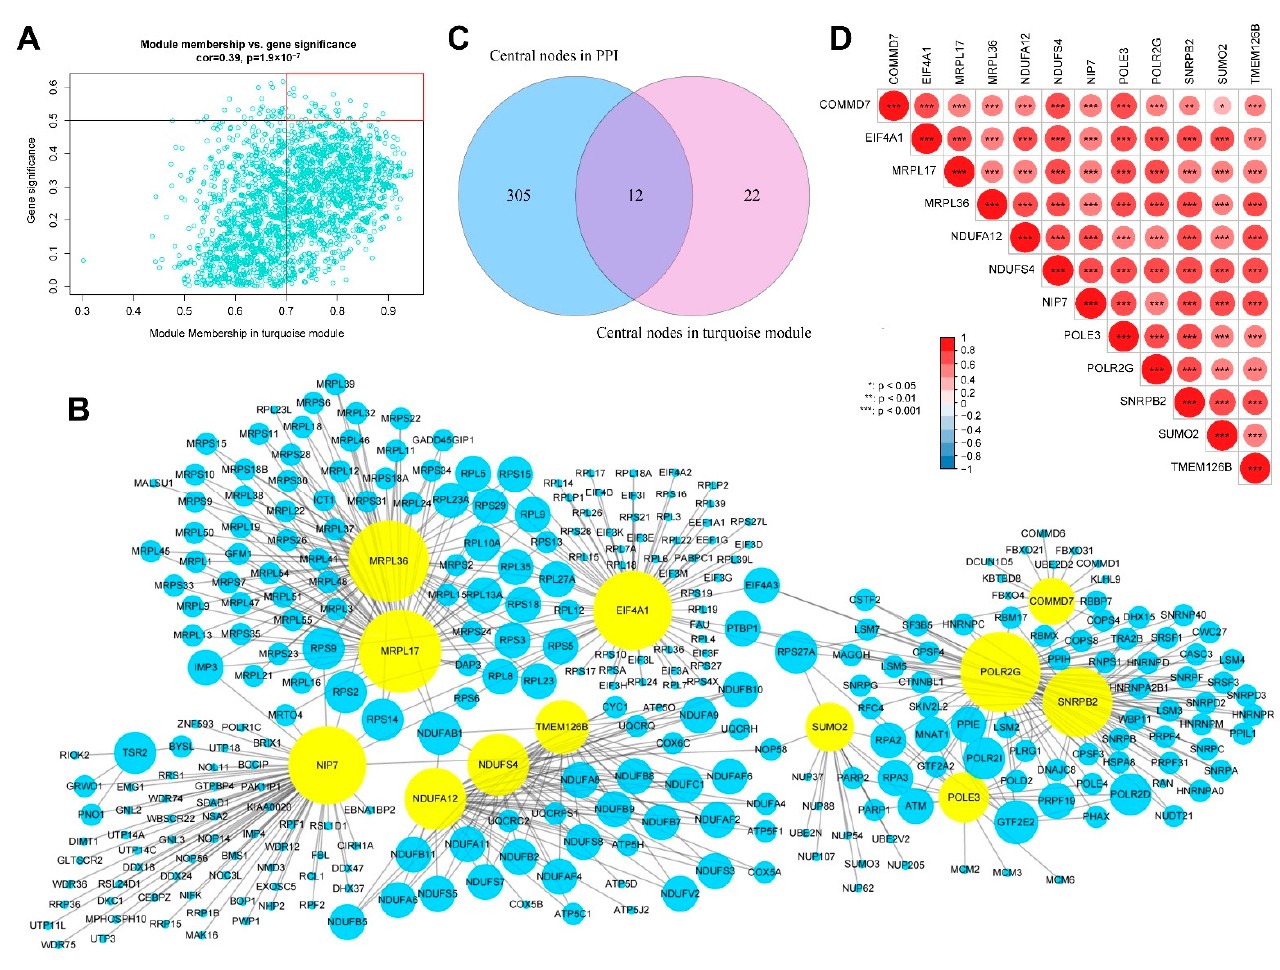
Figure 7. Identification of hub genes. ( A ) Scatter plot of module membership and gene significance in the turquoise module in weighted gene co-expression network analysis (WGCNA). The 34 genes in the upper right area are candidate hub genes. ( B ) Protein–protein interaction (PPI) network of the 317 candidate hub genes identified using Cytoscape. Yellow nodes represent the 12 selected AS-related hub genes. ( C ) Venn diagram shows the intersection between candidate hub genes in WGCNA (blue circle) and PPI (purple circle). ( D ) Pairwise correlation analysis of the 12 hub genes shows significant positive correlations between each gene.